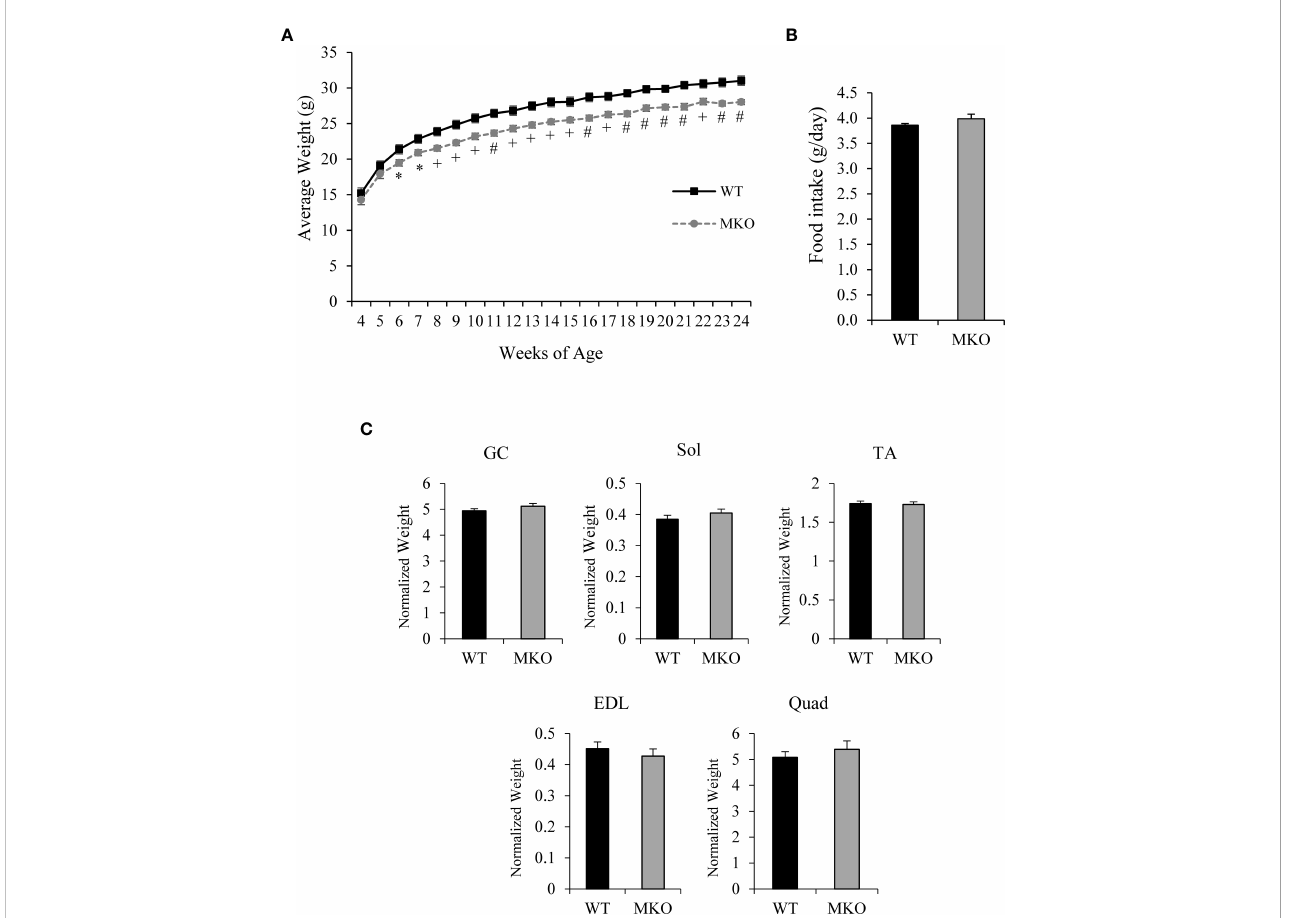
FIGURE 2 The body weight of Arid5b MKO mice was reduced relative to WT mice while food intake and skeletal muscle weights were similar for Arid5b WT and MKO mice. (A) Growth curve of Arid5b WT and MKO mice (n=10). *, p < 0.05; +, p < 0.01; #, p < 0.001. (B) Food intake of Arid5b WT and MKO mice expressed as the means ± SE (WT, n=7; MKO, n=8). (C) Skeletal muscle weights were normalized to body weight, and results are expressed as the means ± SE. (WT, n=14; MKO,